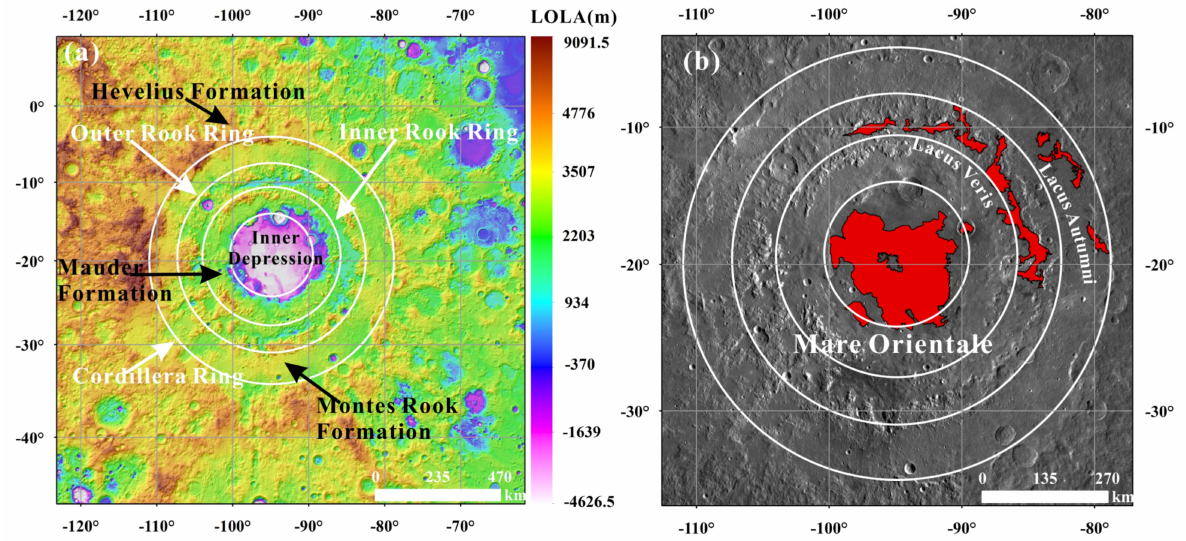
Figure 2. ( a ) Location map of Orientale Basin with four main rings (the rings the basins based on the work of Liu et al. [17]) and deposits labeled (the deposits based on the work of Whitten et al. [20]) in LOLA data; ( b ) The lunar basalts (the basalts based on the work of Morota et al. [10]) of the Orientale Basin in WAC image (108 m/pix). Table 1. The AMAs ages of basalts in the Orientale